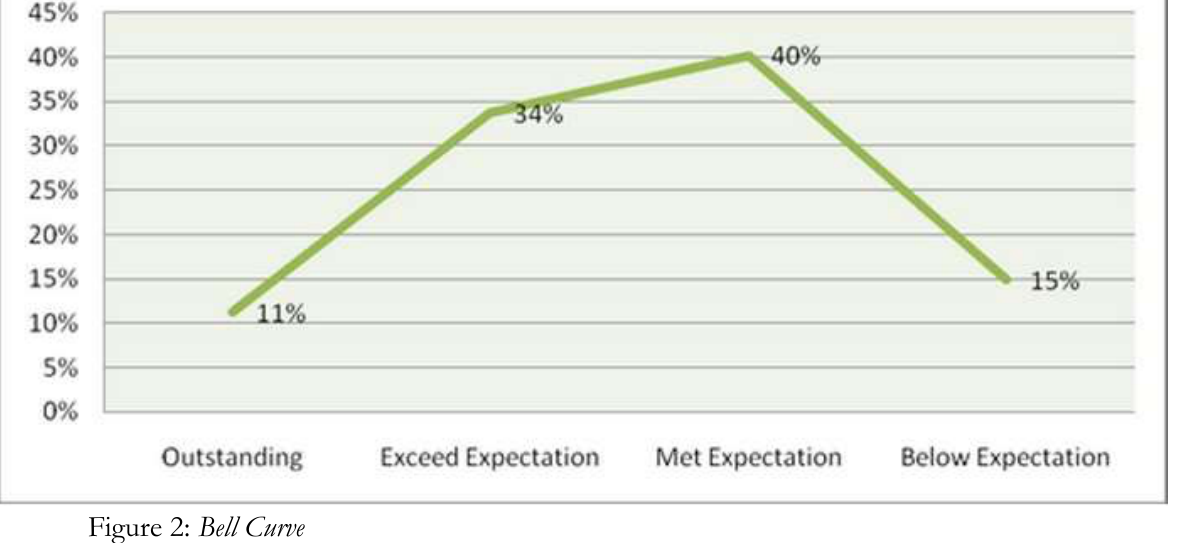
Figure 2: Bell Curve Source: Taken from APA-2011